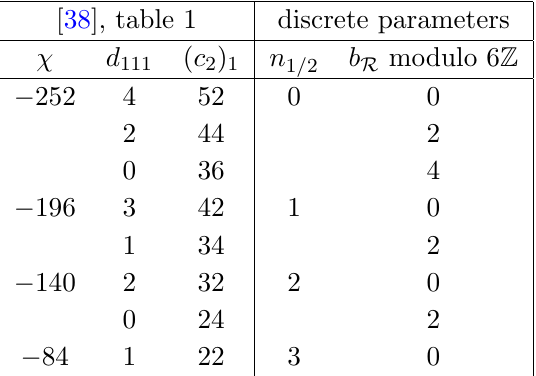
Table 4 . Topological invariants of Calabi-Yau three-folds with a regular h +2 i -polarized K3-(cid:12)bration quoted from [38]. Corresponding parameters ( n shown on the